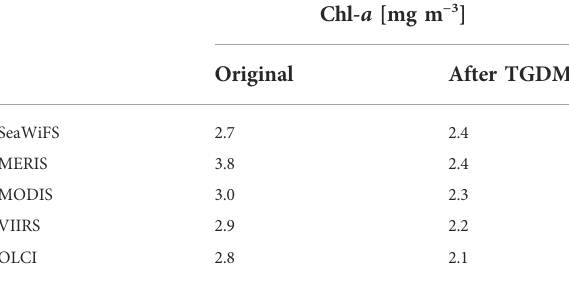
TABLE 2 The average Chl- a per sensor of the pixels nearest to the coast (centre of the pixel located between 0 and 4 km from the coastline) of the original data set and the temporally homogenised data set (i.e. after applying the TGDM).